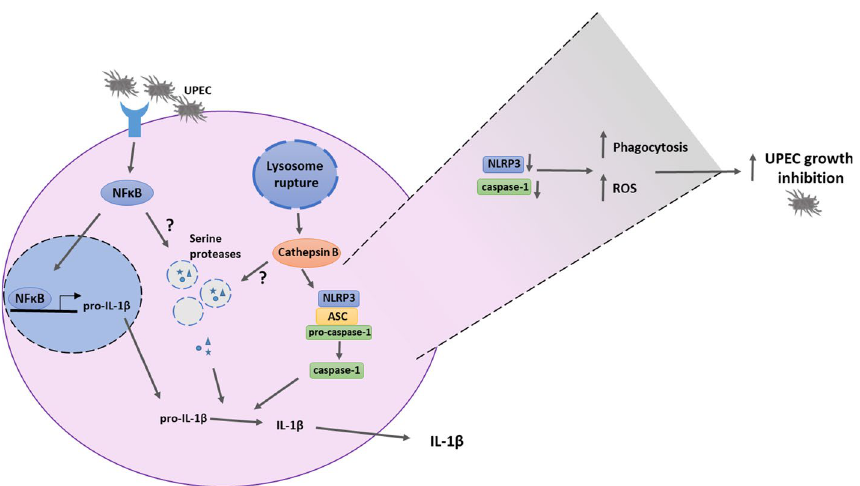
Figure 7. A schematic overview summarizing the main findings. UPEC strain CFT073 induced an increased pro-IL-1β mRNA expression, caspase-1 activation and IL-1β release from human neutrophils. The IL-1β release was mediated by the NLRP3 inflammasome and serine proteases in an NF-κB- and cathepsin B-dependent manner. Additionally, inhibition of NLRP3 and caspase-1 increased neutrophil ROS-production, phagocytosis and the ability of neutrophils to suppress UPEC